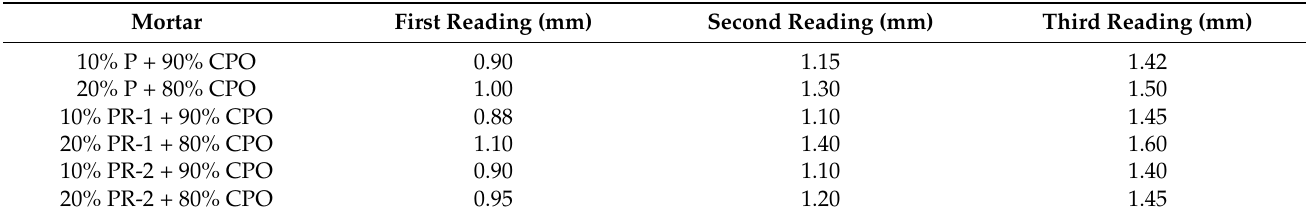
Table 2. Laboratory measurements to determine volume